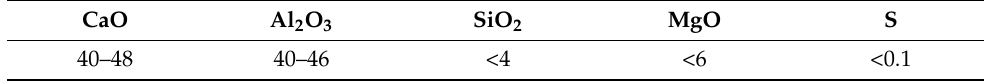
Table 2. Chemical composition range of the premelted refining slag (wt%).